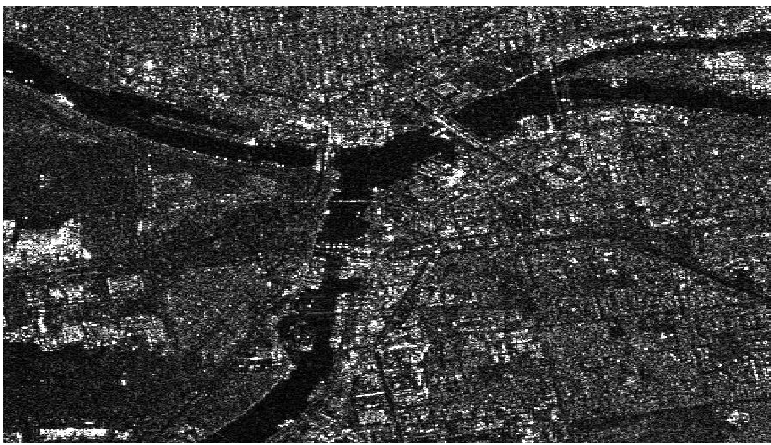
Figure 1. Example of single look image detected by the Sentinel-1